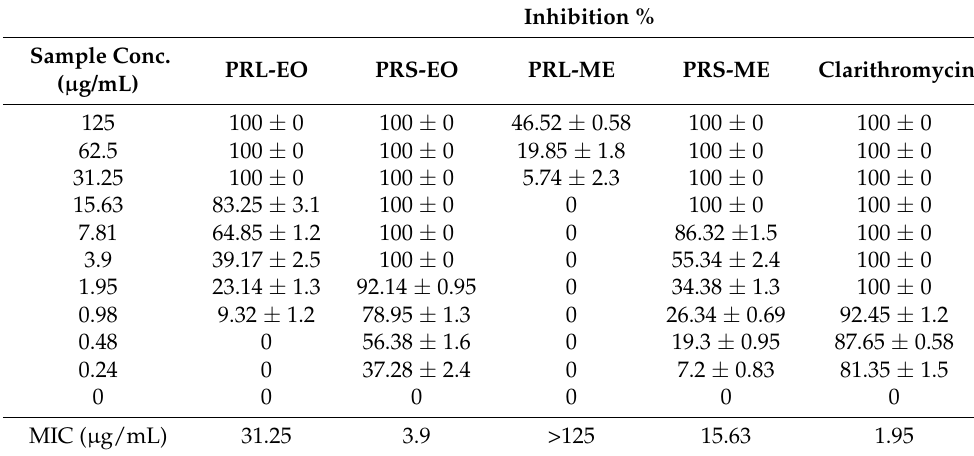
Table 3. Anti-helicobacter pylori activity of essential oils and methanol extracts of P. racemosa leaves and stems.